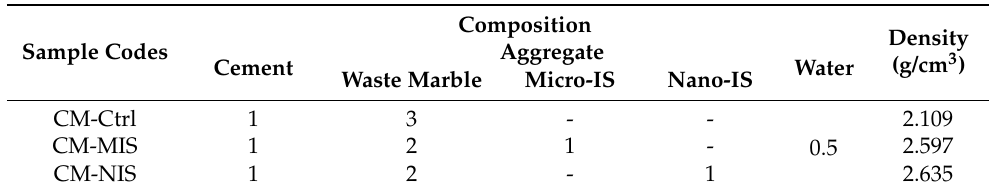
Table 2. The density and the mixing ratios of the mortar samples.